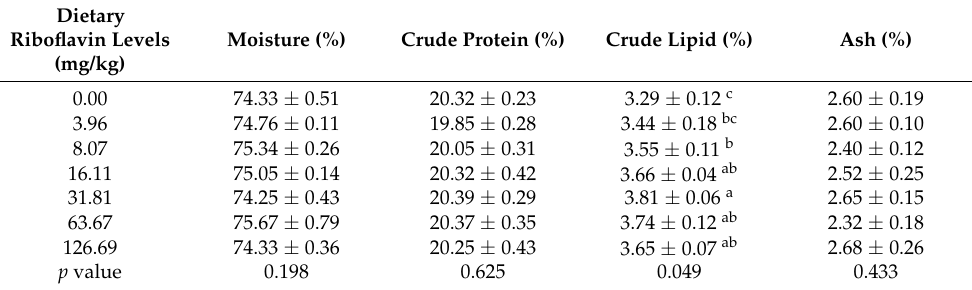
Table 3. Effects of dietary riboflavin levels on the muscle proximate compositions of coho salmon ( Oncorhynchus kisutch ) post-smolts for 12 weeks.